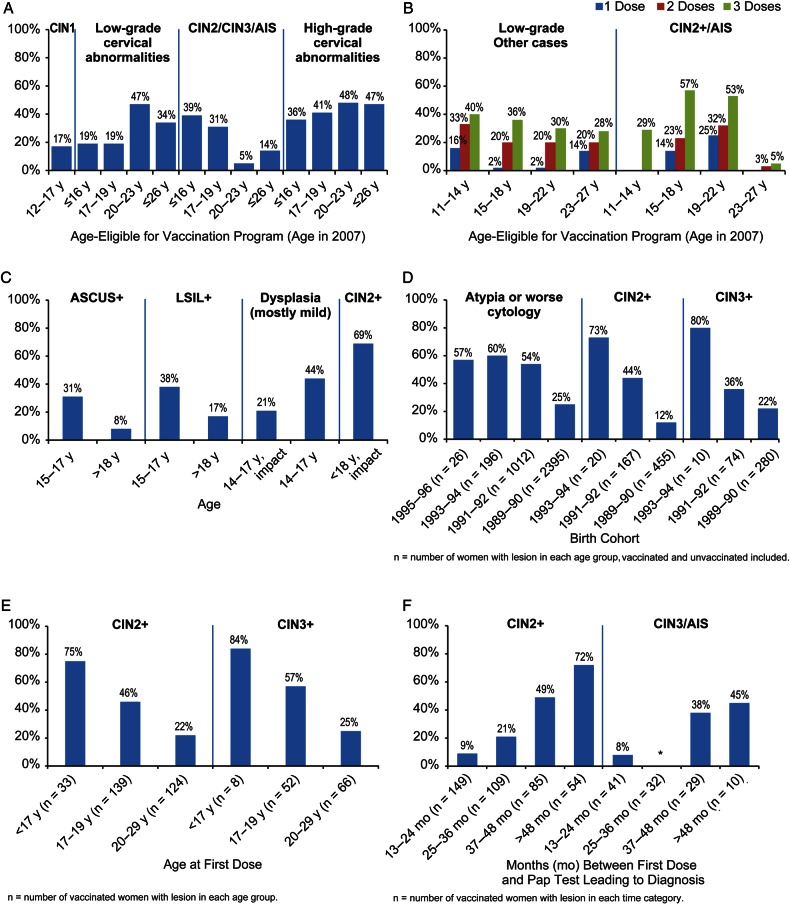
Impact and effectiveness of quadrivalent human papillomavirus (4vHPV) vaccination on cervical cytological and histological abnormalities. In Panel B, “2 doses” indicates receipt of an incomplete 3-dose schedule and not a primary 2-dose schedule. More details of the studies shown in the panels of Figure 3 are provided at the end of Supplementary Appendix II. A, Australia: population-based analysis of percentage reduction in cervical abnormalities among vaccinated (at least 1 dose) vs contemporaneous unvaccinated screened females in Victoria [A46, A44]. B, Australia: population-based analysis of percentage reduction in cervical abnormalities among vaccinated vs contemporaneous unvaccinated screened females in Queensland [A45]. C, Canada: percentage reduction in cervical abnormalities in vaccinated/vaccine era vs contemporaneous unvaccinated/prevaccine era in 3 provinces [A47, A20, A58]. D, Denmark: percentage reduction in cervical abnormalities in females vaccinated with 4vHPV vaccine (≥1 dose) vs unvaccinated women by birth cohort [A48]. E, Sweden: percentage reduction in CIN2+ and CIN3+ among females fully vaccinated with 4vHPV vaccine (3 doses) vs unvaccinated/partially vaccinated females, by age at first dose [A50]. F, United States: percentage reduction in HPV 16/18-related cervical abnormalities among females vaccinated with 4vHPV vaccine (at least 1 dose) vs contemporaneous unvaccinated females, by time between first dose and screening test leading to diagnosis; *null: adjusted prevalence ratio 1.02 [A49]. Abbreviations: AIS, adenocarcinoma in situ; ASCUS, atypical squamous cells of undetermined significance; CIN2/3, high-grade cervical intraepithelial neoplasia; LSIL, low-grade squamous intraepithelial lesion.